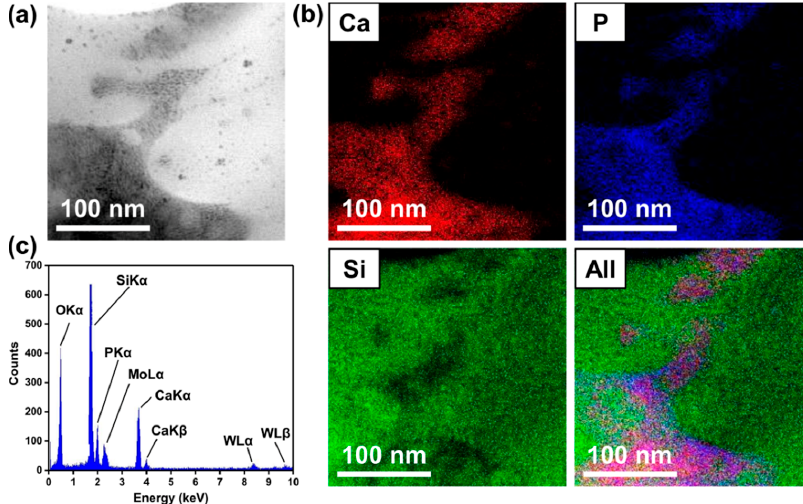
Figure 5. ( a ) STEM image, ( b ) EDX mapping images, and ( c ) elemental composition of LMSP12h.